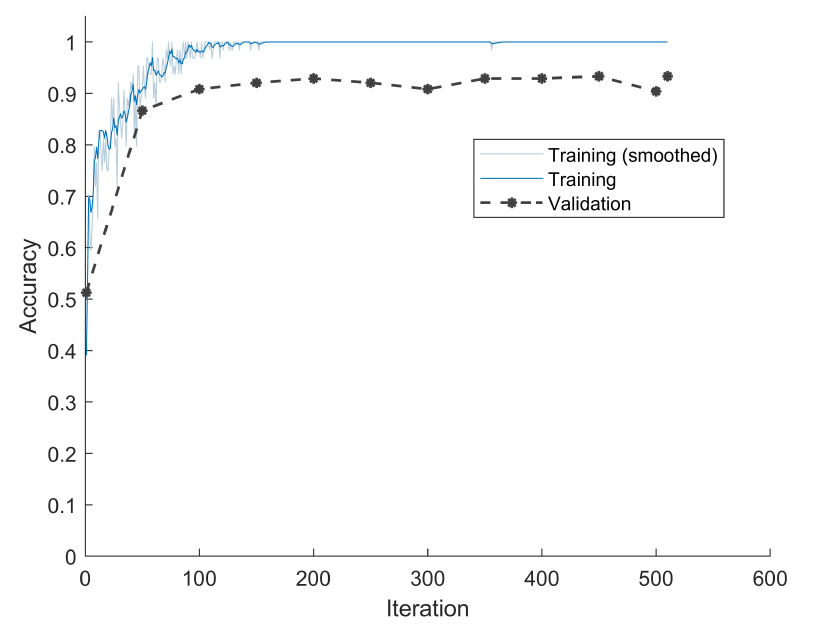
Figure 7. Classification accuracies and loss during training and validation for DC values after DPCM. The accuracy curve shows that even using only DC value after DPCM, the LSTM model converges well after certain